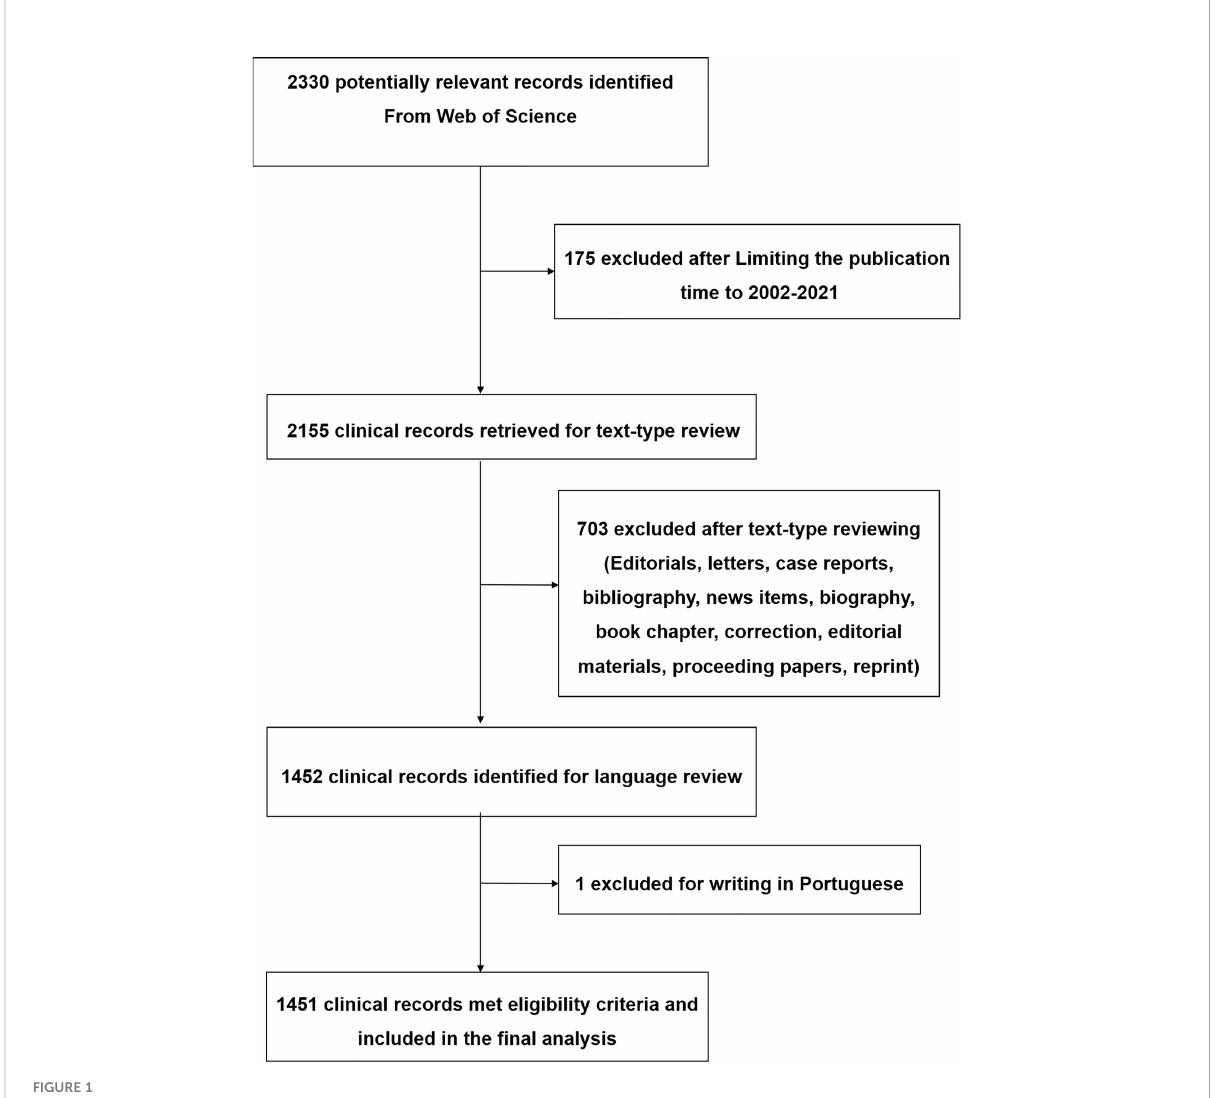
FIGURE 1 Flow diagram of research selection and